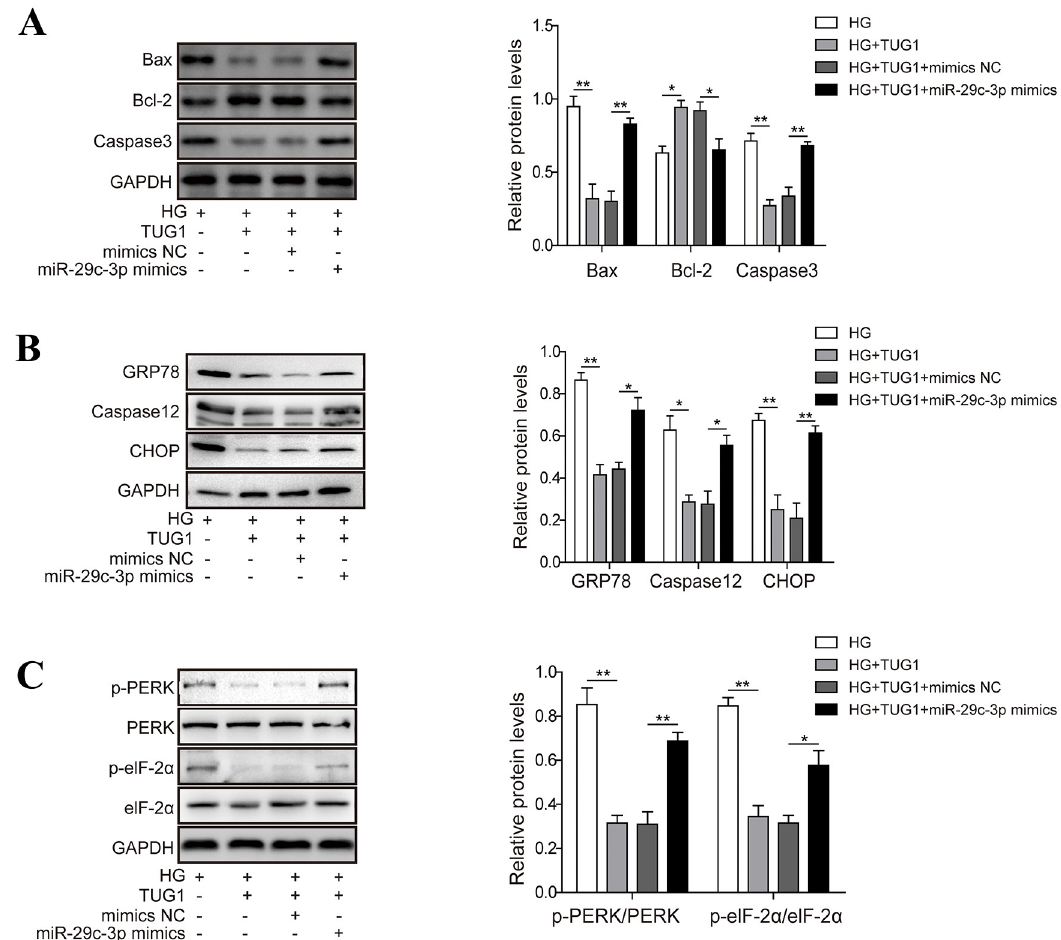
Fig 6. The protective role of TUG1 is dependent on its ability to downregulate miR-29c-3p expression. (A-C) HK-2 cells were treated as described in Fig 5, the expression of pro-apoptotic and anti-apoptotic proteins (A), or the expression (B) and phosphorylation (C) of ERS-associated proteins were examined by western blot. Data were mean ± SD and were representative of three independent experiments. � p < 0.05, �� p < 0.01.